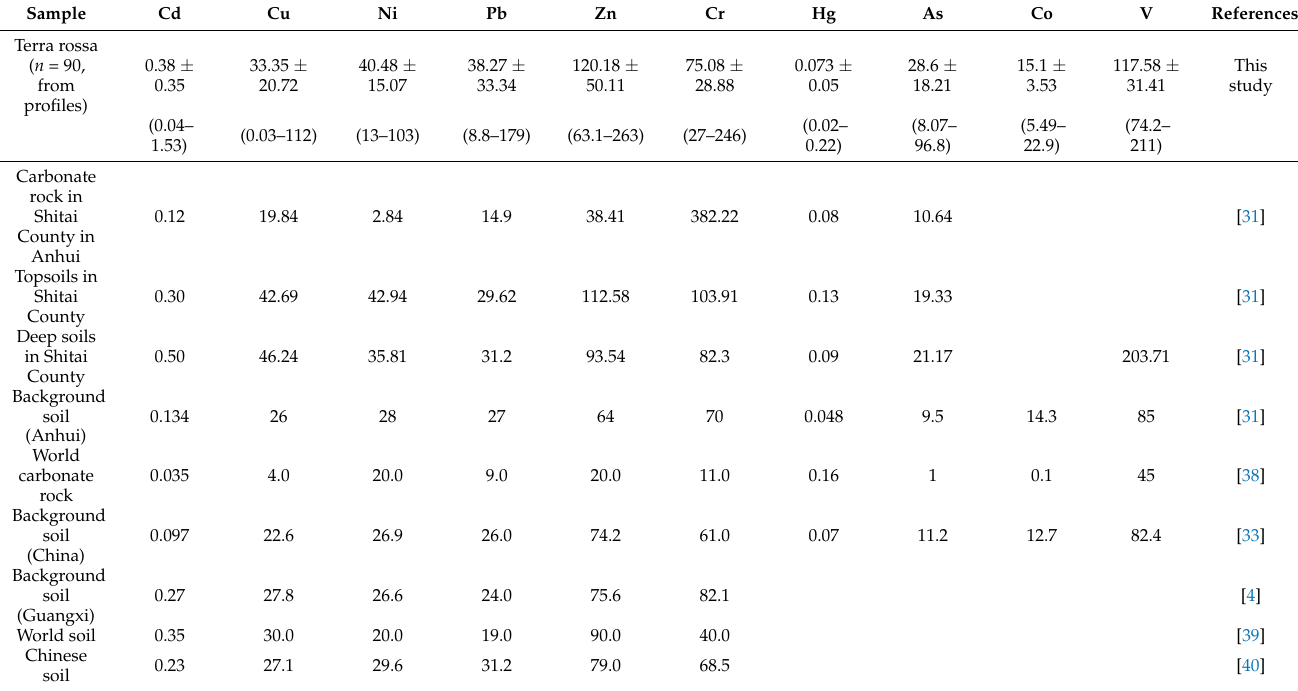
Table 2. HM concentrations (mg/kg) in terra rossa from the weathering profiles across the study